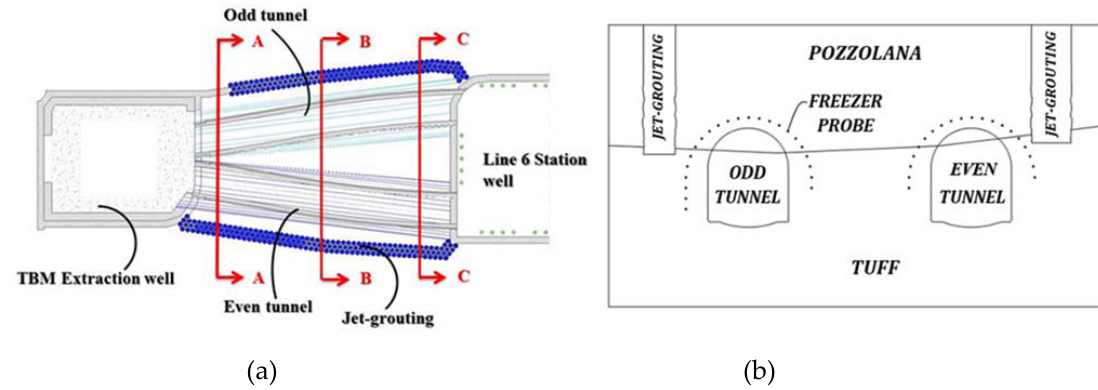
Figure 3. (a) Key plan of the tunnels and freezing probes, with indication of the three cross sections considered; (b) cross section of the case study with the position of the freezing probes.